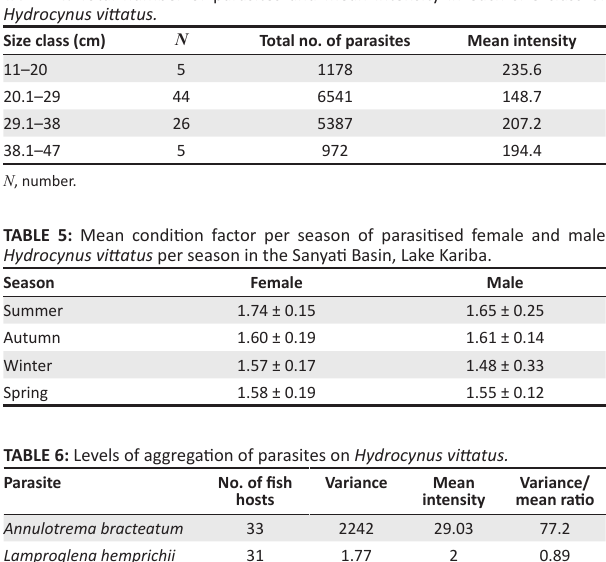
Variance Mean Variance/ hosts intensity mean ratio